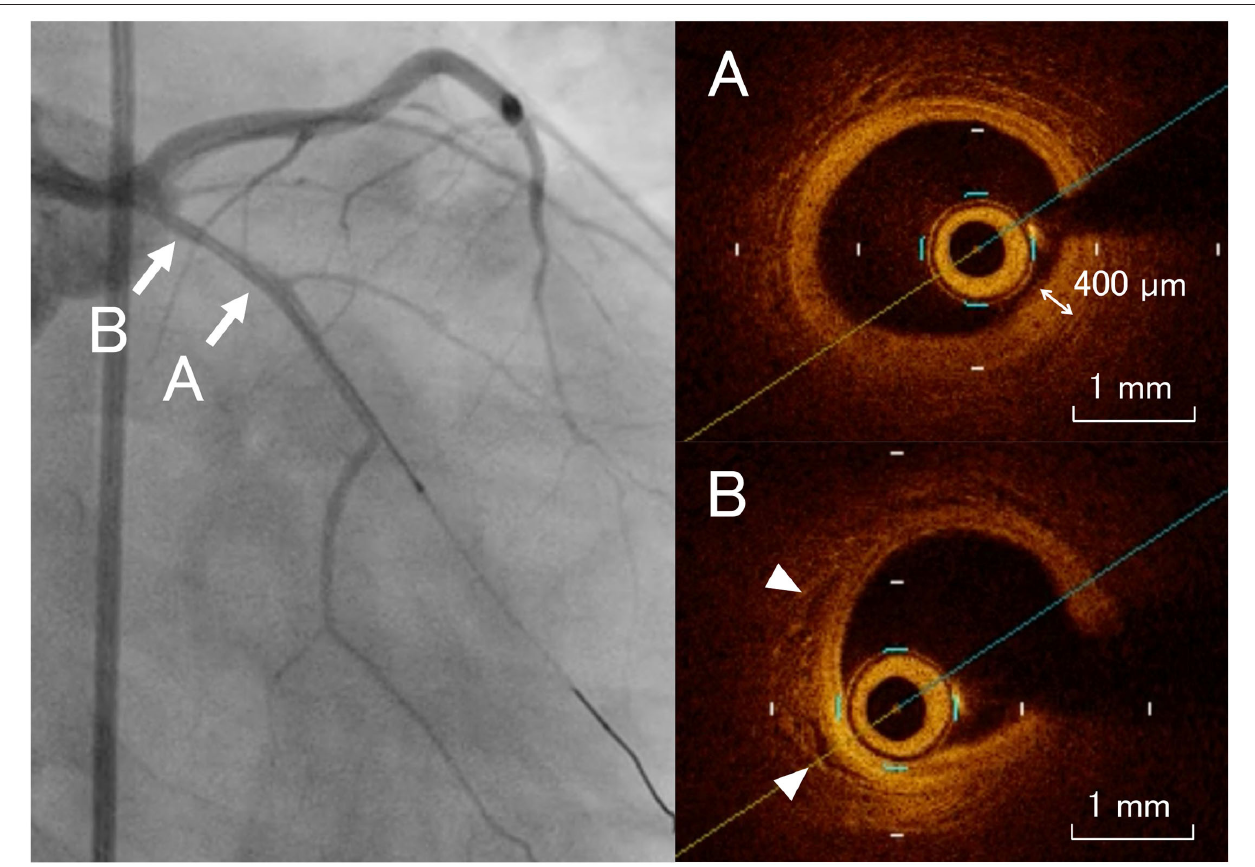
FIGURE 2 | Coronary angiogram images with the corresponding optical coherence tomography examinations. The left anterior descending artery shows intimal thickening, disruption of the media (A) , and neovascularization [ (B) arrowheads].